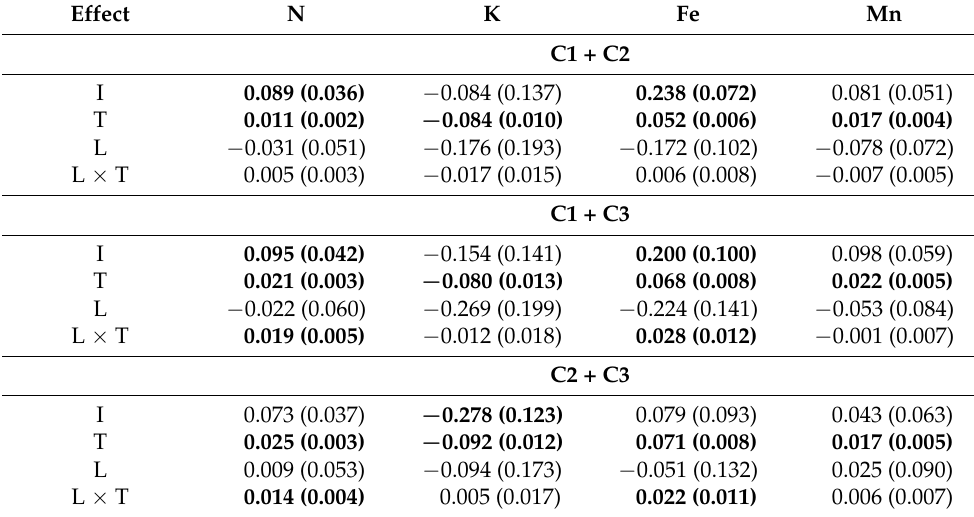
Table 3. Coefficients obtained from the adjustment of the generalized linear mixed models for the remaining nutrient concentration of P. taeda forest litter according to the comparison